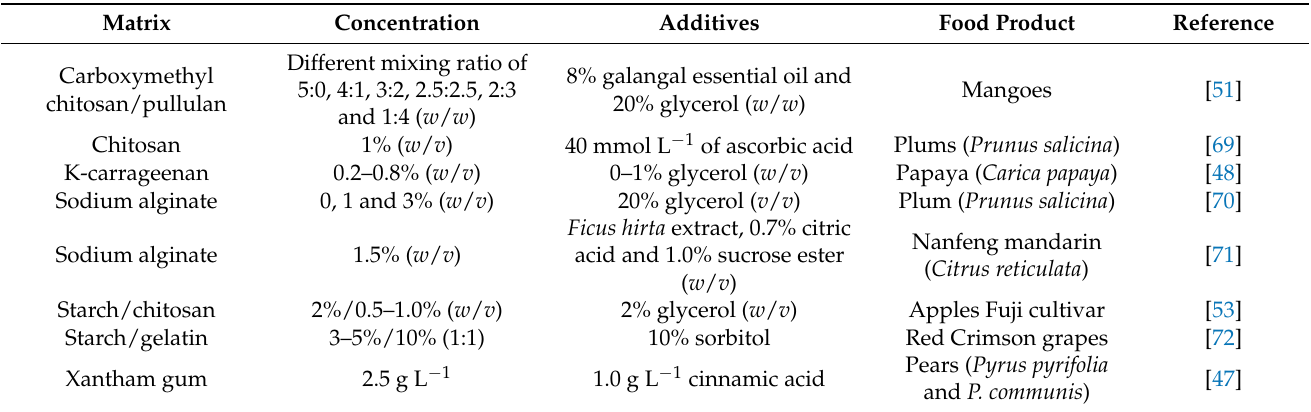
Table 2. Edible coatings applied on